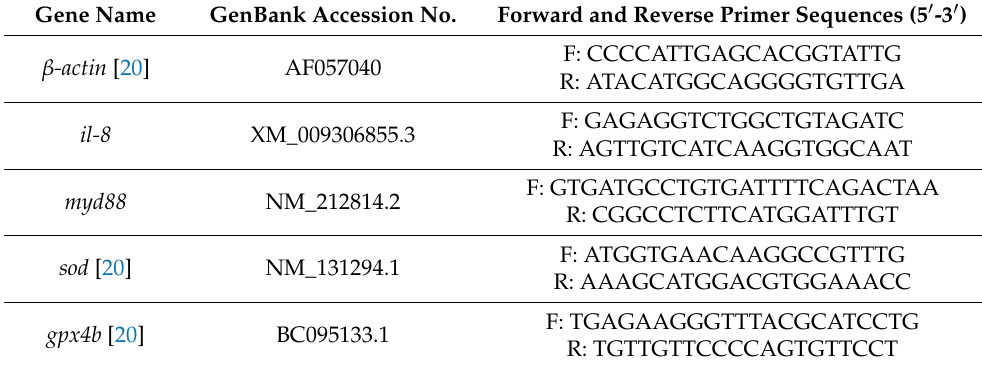
Table 1. Primers used in this